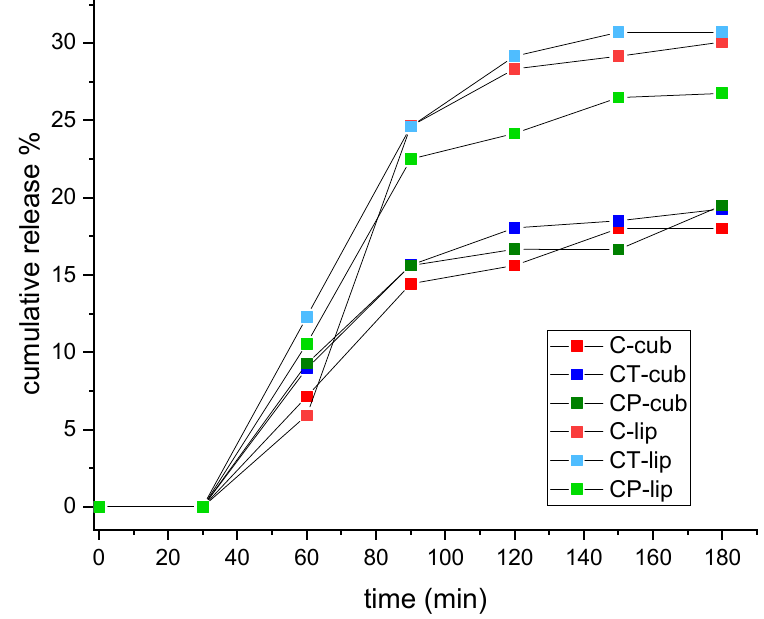
Figure 1. Cumulative release % curves throughout 3 h total SGF/SIF digestion time.